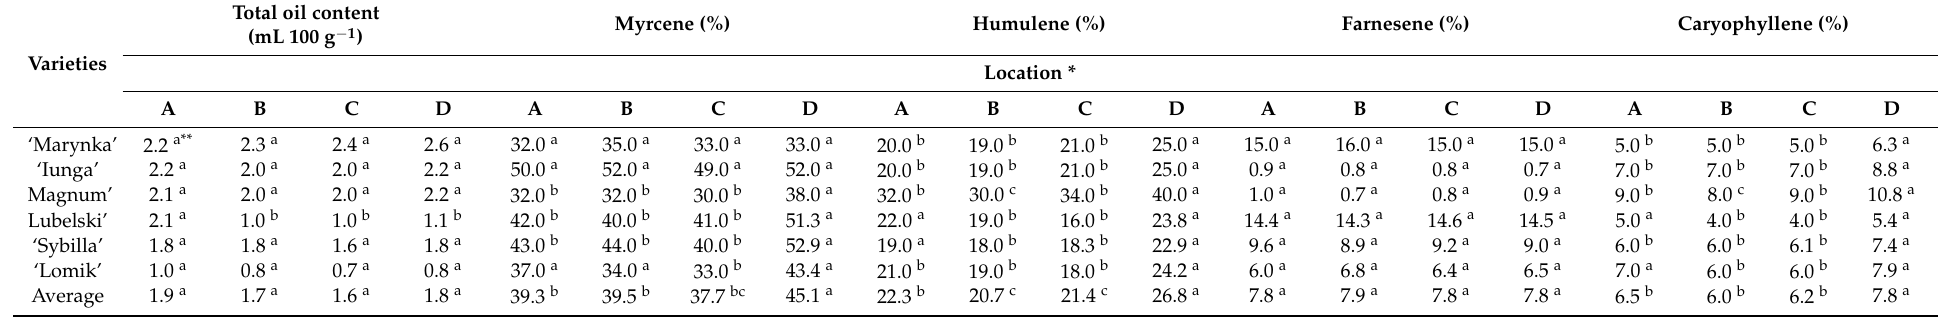
Table 15. The influence of location and varieties on the content of total oils and the share of myrcene, humulene, farnesene and caryophyllene (2015–2017).